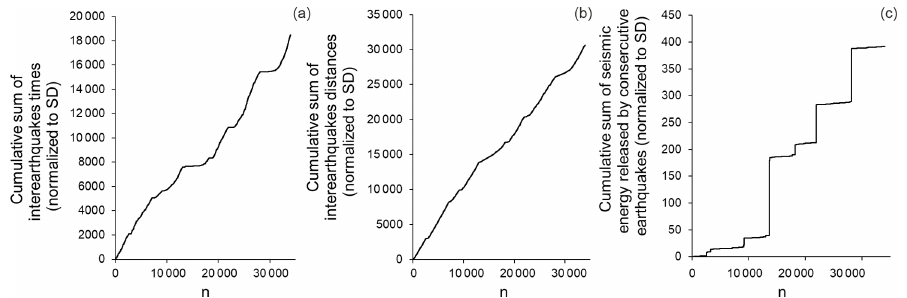
Figure 2. Cumulative sums of (a) interevent times; (b) inter-earthquake distances; and (c) released seismic energies, starting from the first event in the southern California catalogue